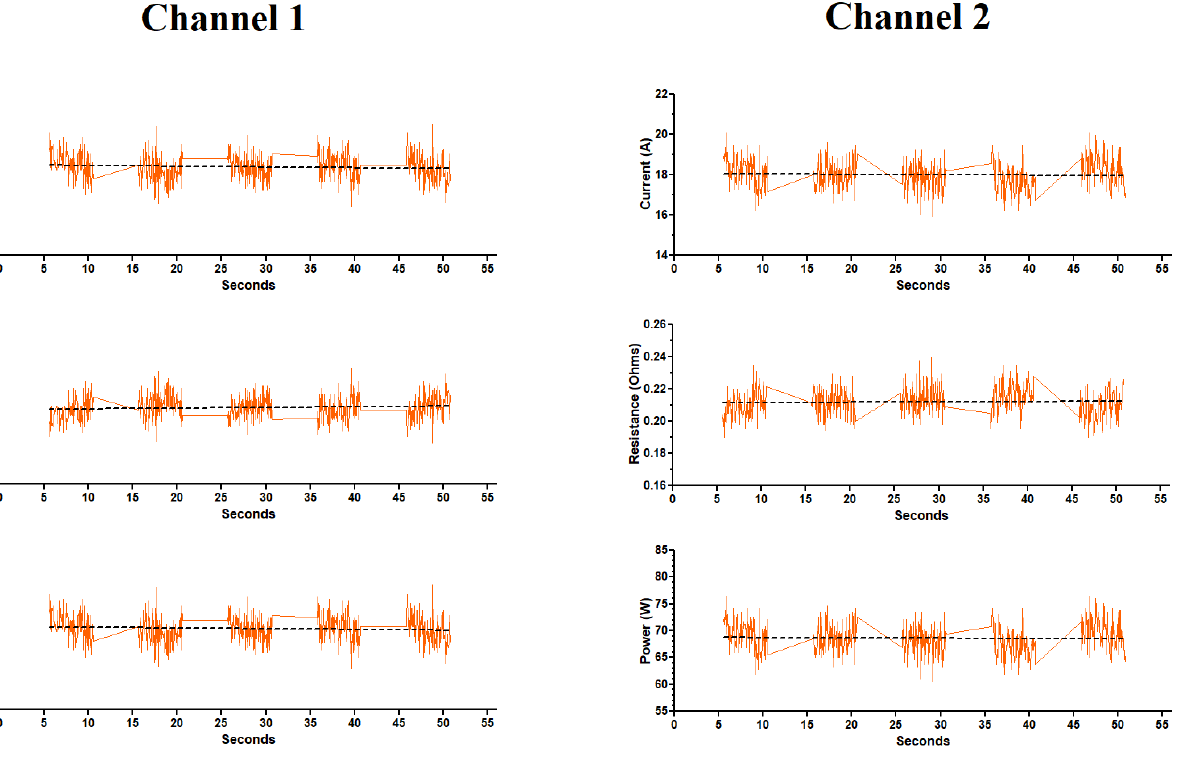
Figure 5. Electrical parameter profiles during the first five puffs of the ECIG aerosol generator running both channels simultaneously. Dashed line represents the trend line for each parameter.